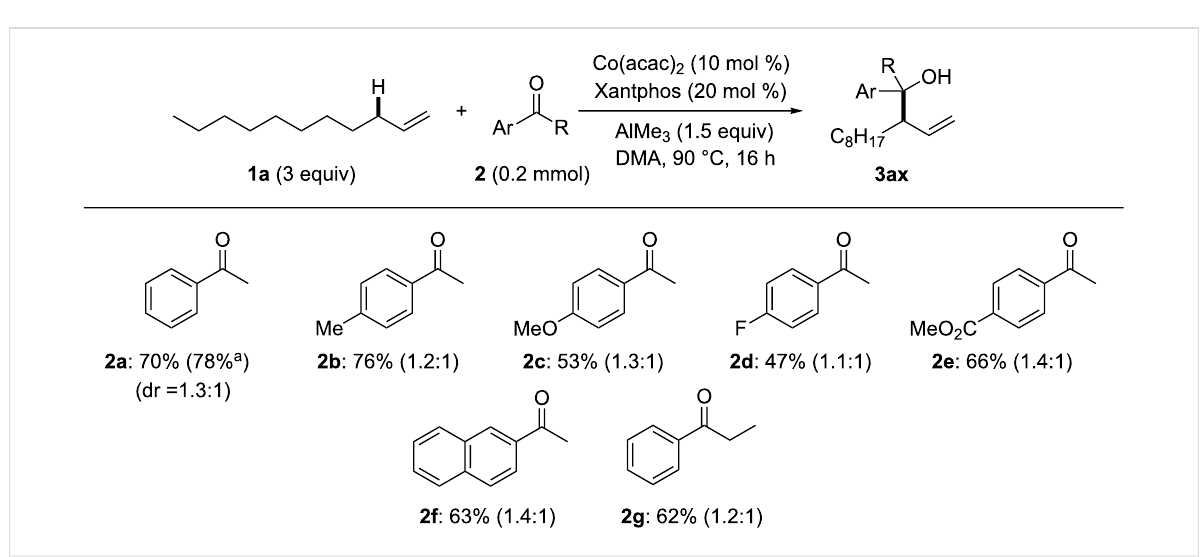
Figure 2: Substrate scope for acetophenone derivatives. a Preparative scale synthesis using 1 mmol of 2a .